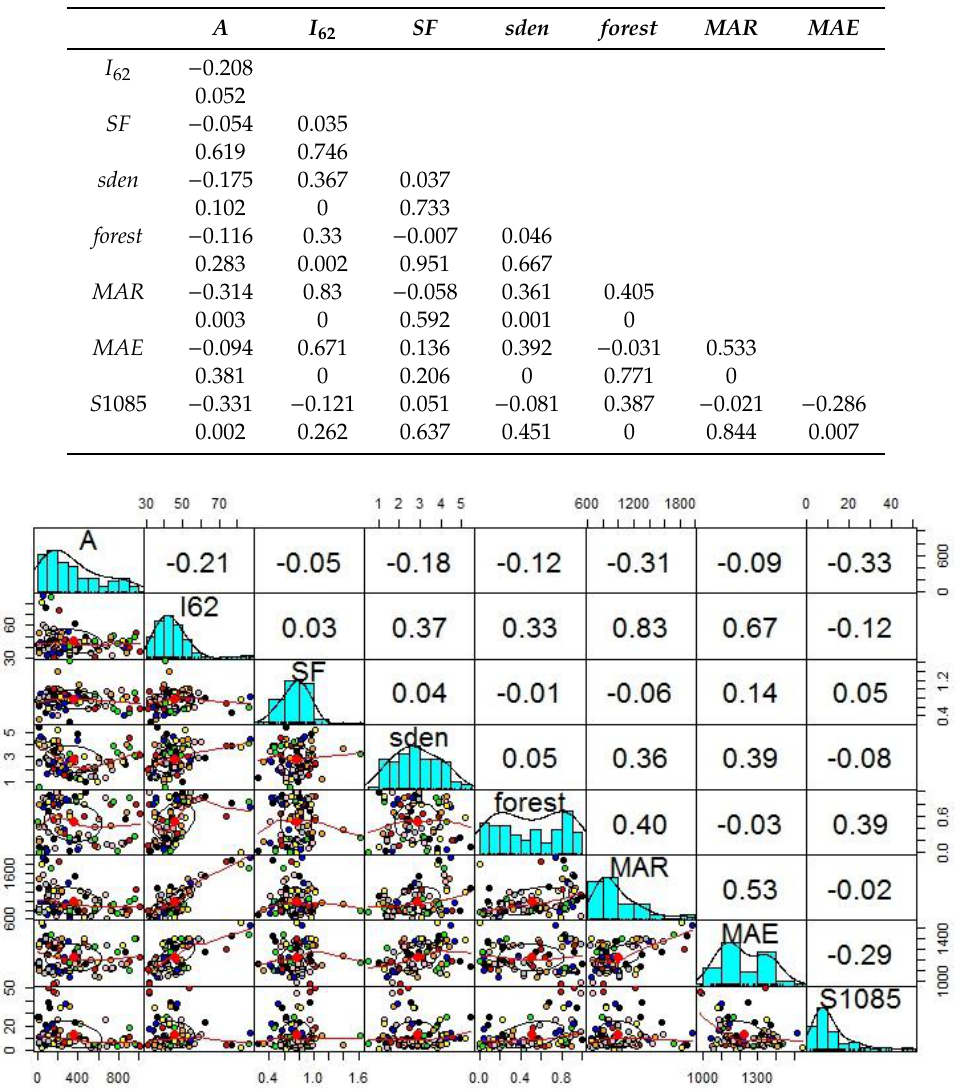
Figure 2. Correlation between the predictor variables before applying principal component analysis